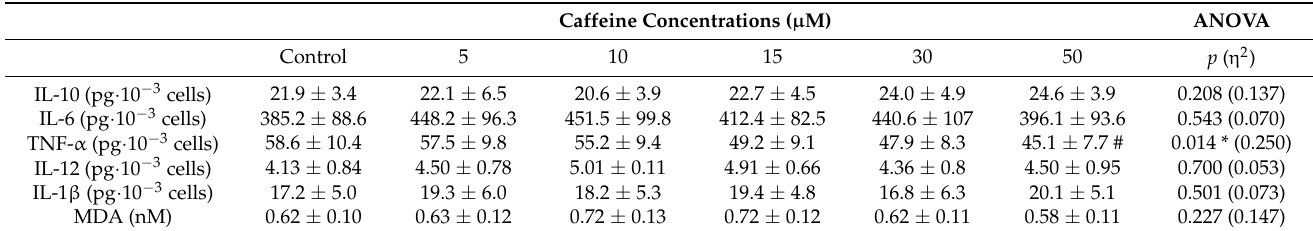
Table 2. Effects of caffeine on LPS-stimulated cytokine production and MDA